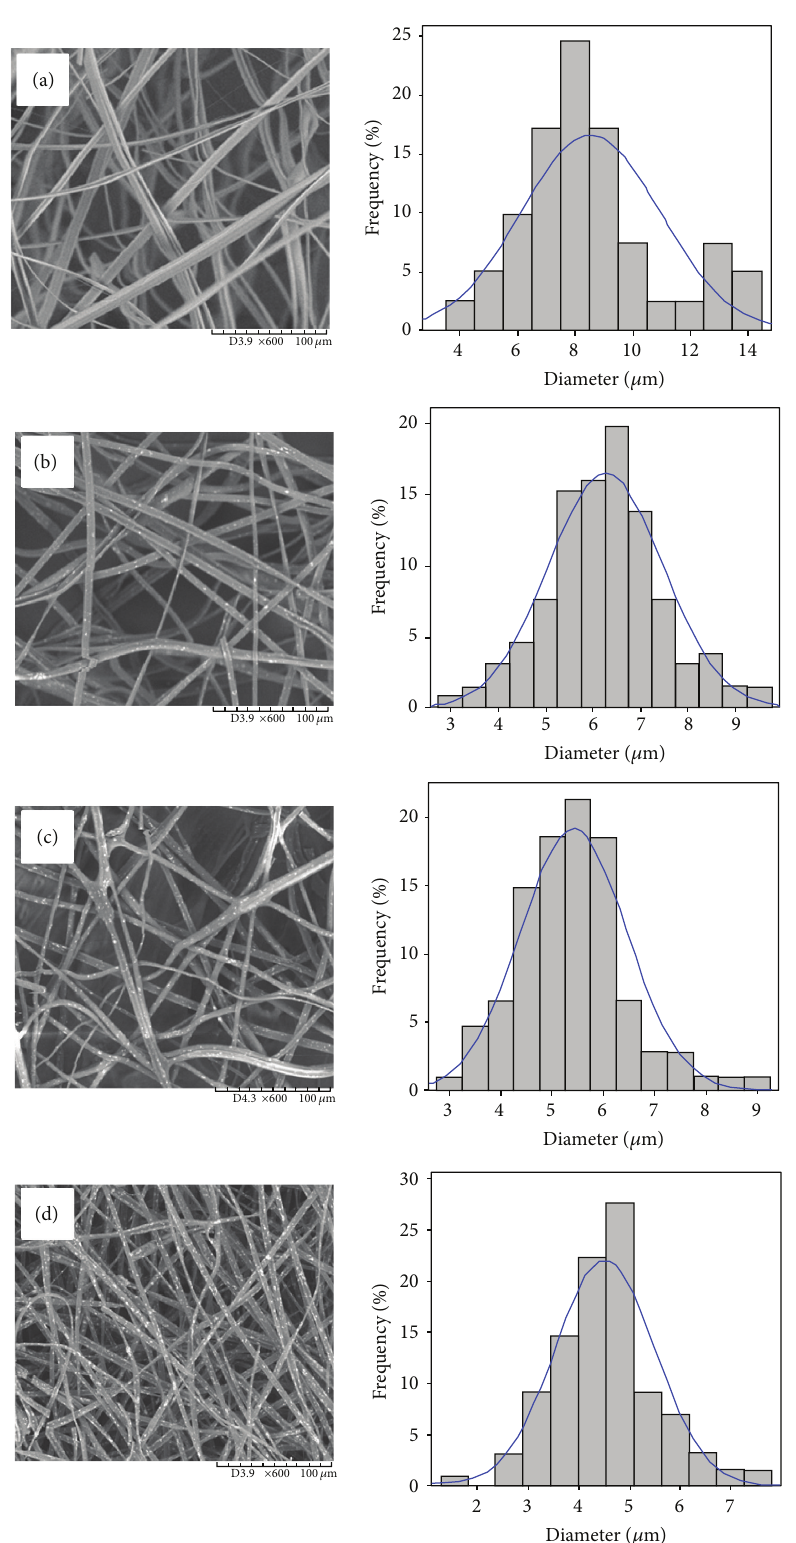
Figure 4: SEM images of electrospun fibers with increasing concentration of loaded-TiO 2 (pristine EDGT (a), 2 wt% of TiO 2 in EDGT fibers (b), 4wt% of TiO 2 in EDGT fibers (c), and 6 wt% of TiO 2 in EDGT fibers